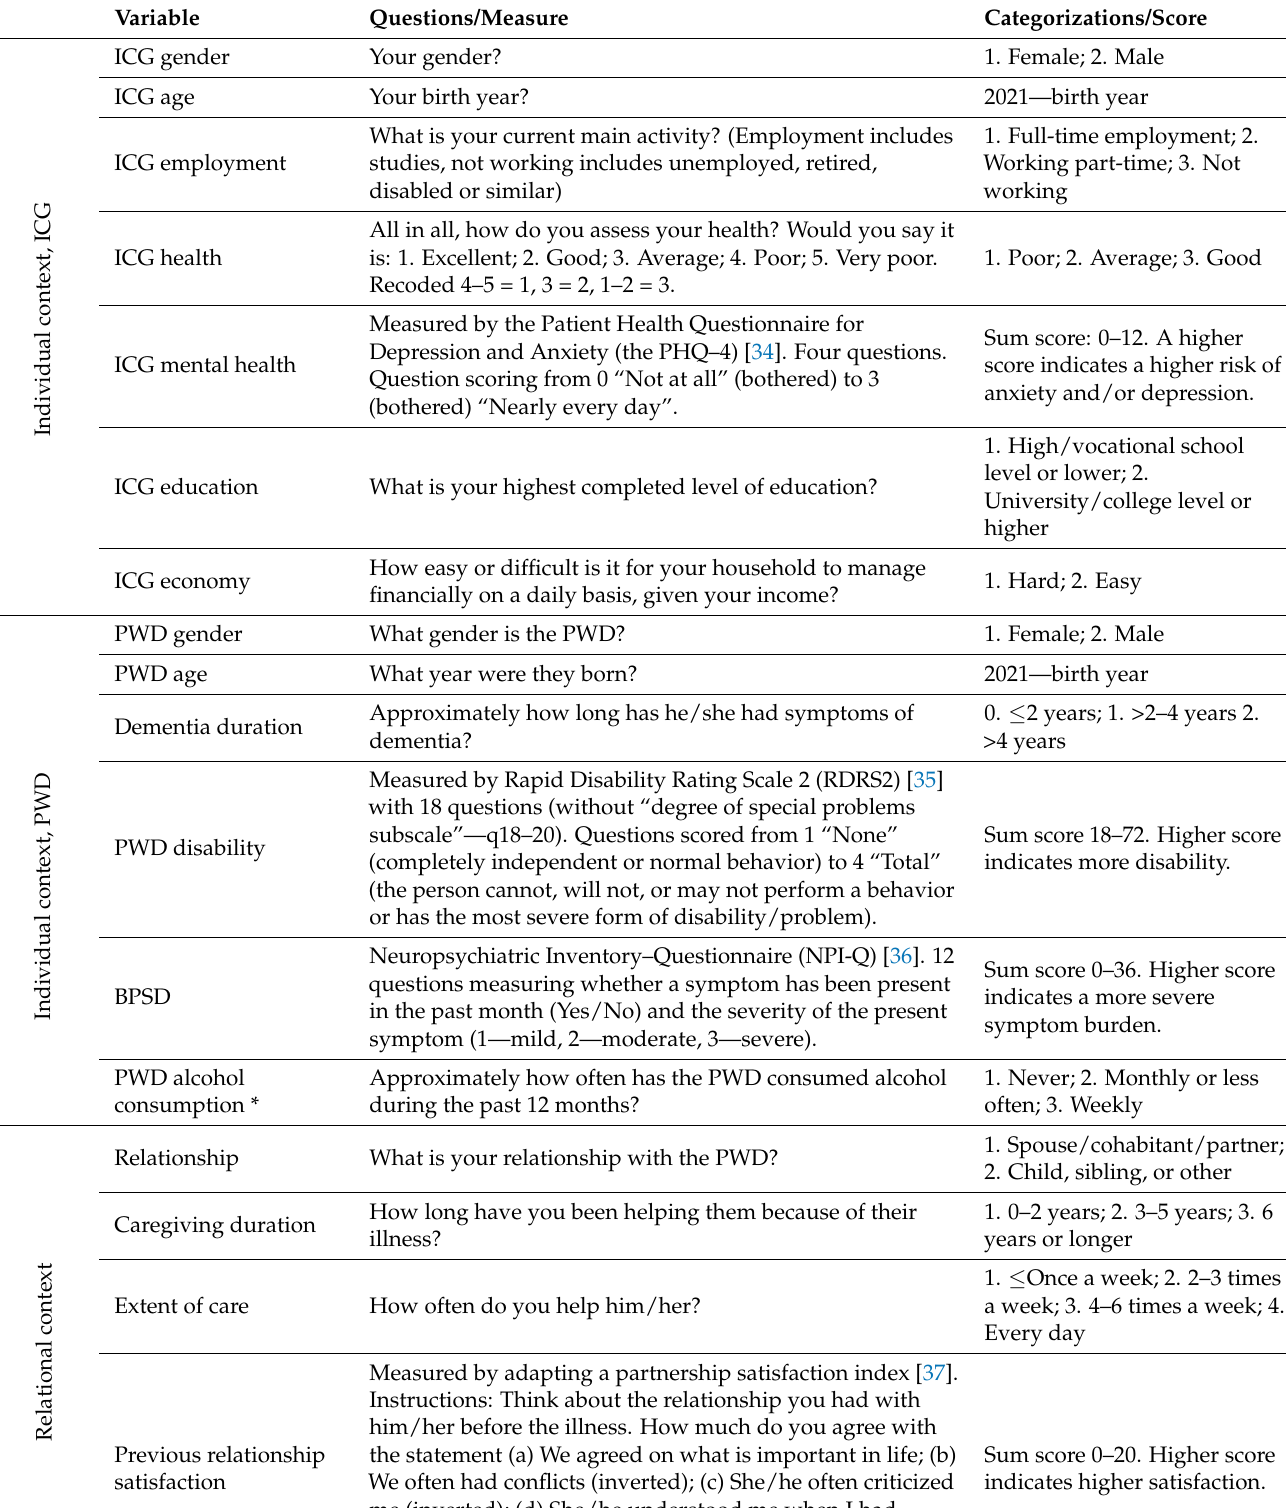
Table 1. Descriptions of the